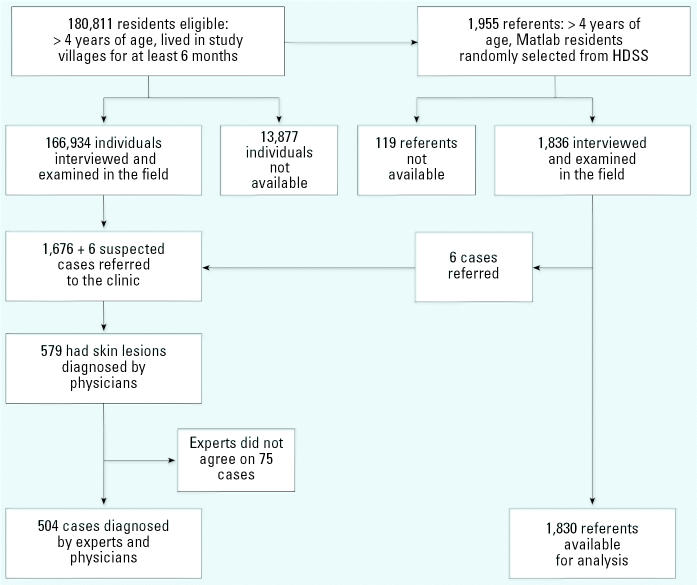
Flow chart showing case identification and selection of referents.